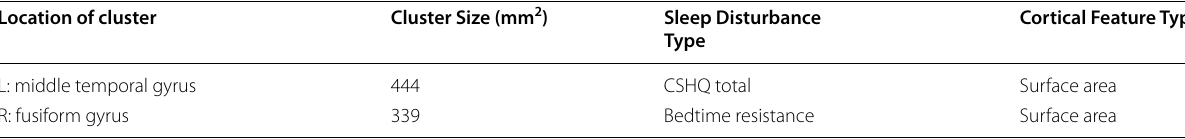
0.05) between sleep disturbance scores and ≤